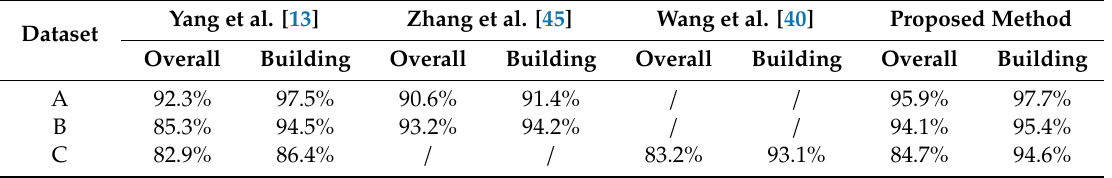
Table 5. Performance comparison between the proposed method and